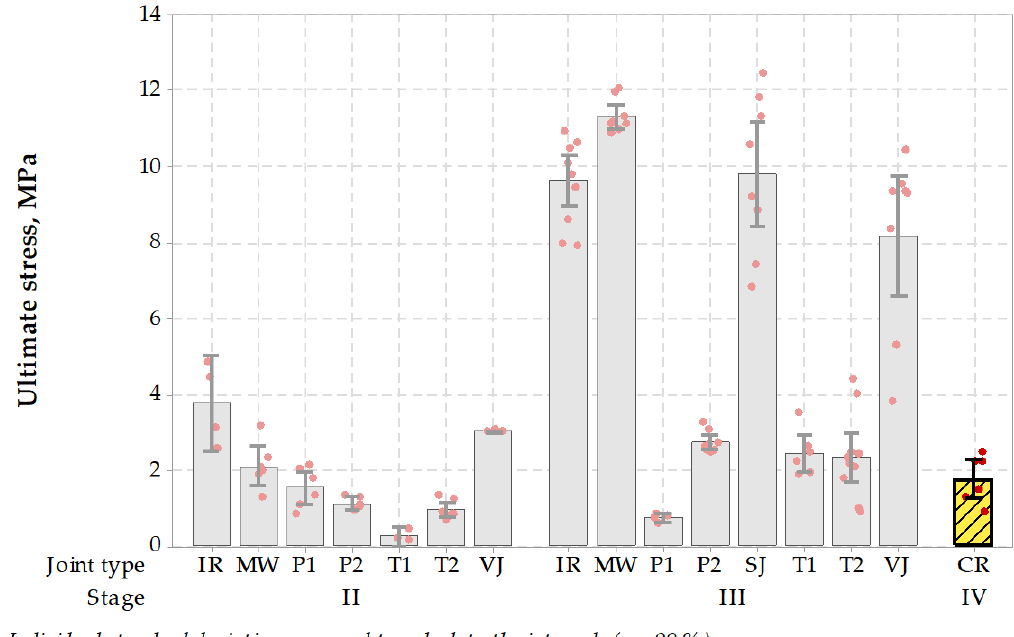
Figure 15. Semi-circular bending test results of the specimens from the repaired crack (CR, stage IV) compared to longitudinal joints (the higher, the better).